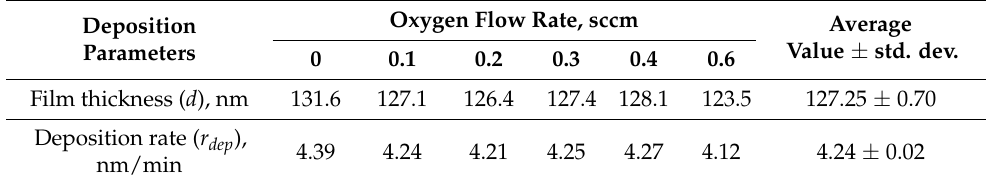
Table 1. Thickness and deposition rate of the as-deposited ITO50:Al 2 O 3 (PHS) thin films at different oxygen flow rates. Average value of deposition parameters in the oxygen flow rate range from 0.1 to 0.4